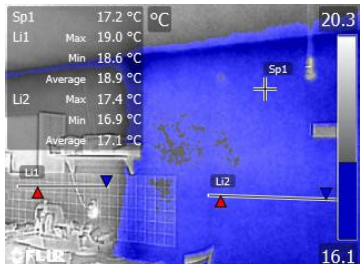
Figure 3. Absence of the outer envelope insulation through a homogenous thermal flow analysis.